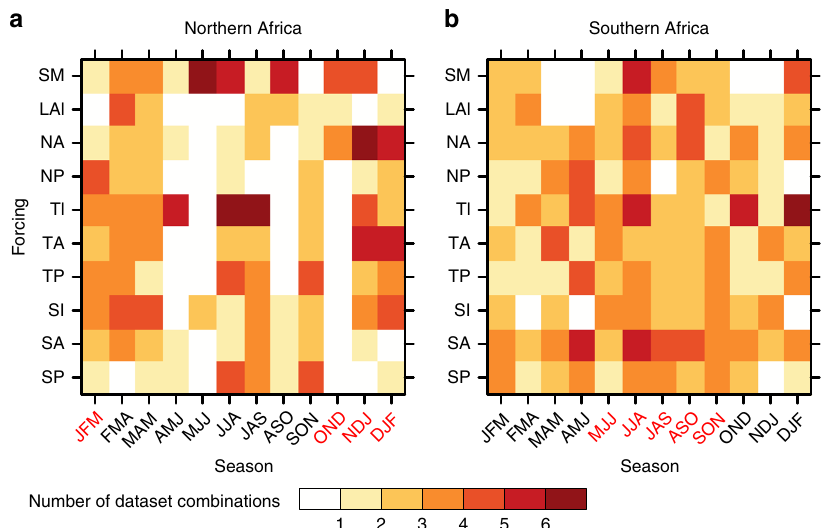
Fig. 1 Robustness of controls on African fi re by season. The multi-dataset robustness of oceanic and terrestrial controls on African fi re carbon emission is assessed by the Stepwise Generalized Equilibrium Feedback Assessment (SGEFA) by season. Color represents the number of dataset combinations [out of the currently examined six dataset combinations (Supplementary Table 1)] that indicate signi fi cant ( p < 0.1) response of regional average fi re carbon emission to either of the leading two principal components ’ (PCs) time series corresponding to the sea-surface temperature (SST) empirical orthogonal functions (EOFs) from eight oceanic basins [North Atlantic (NA), North Paci fi c (NP), tropical Indian (TI), tropical Atlantic (TA), tropical Paci fi c (TP), South Indian (SI), South Atlantic (SA), and South Paci fi c (SP)], and regional average leaf area index (LAI) and 0 – 10 cm soil moisture (SM), across a northern Africa and b southern Africa. In both a , b , labels on the x -axis stand for 3-month seasons, for example, January – March (JFM) for January, February, and March. The fi re-active season is highlighted with red x -axis labels. The forcings are detailed in the Methods